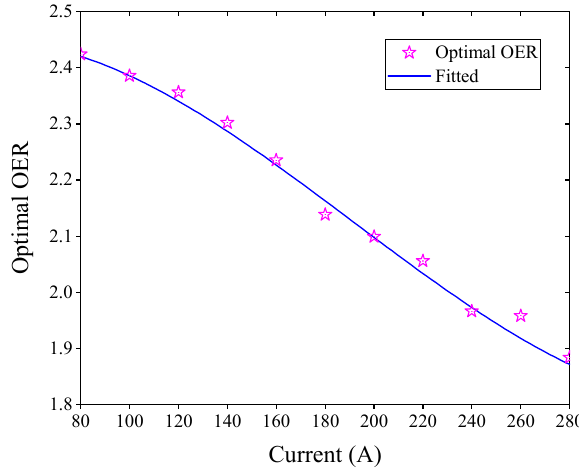
Figure 3. Fitted curves of the optimal OER.